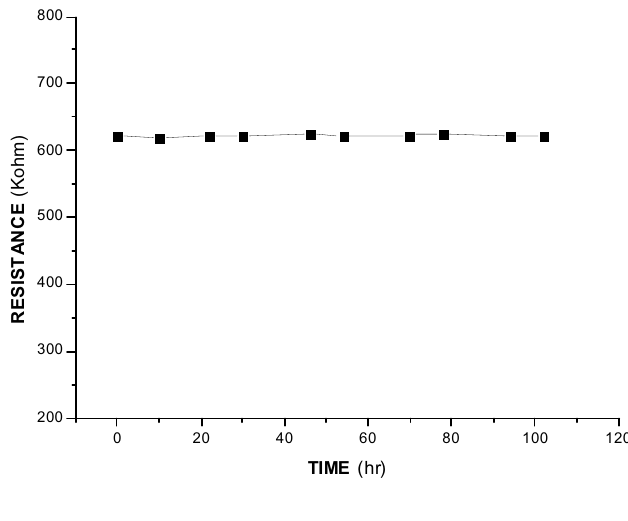
Figure 6. Resistance stability of ZnGa